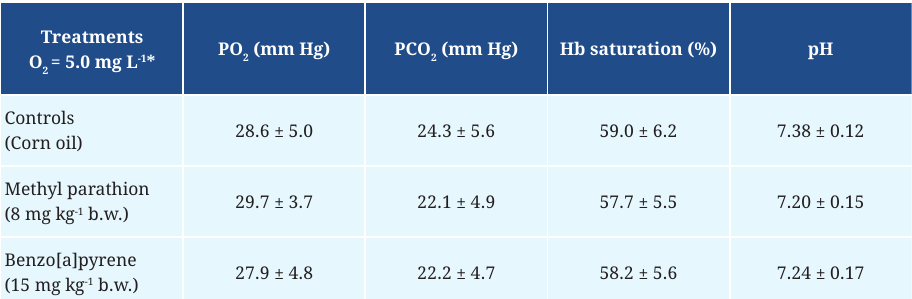
TABLE 1 | Oxygen partial pressure (PO of hemoglobin (Hb) and pH in blood from Piaractus mesopotamicus injected with parathion or benzo[a] pyrene. Numbers are means ± standard error of mean from 15 animals. *Concentration of oxygen in water.